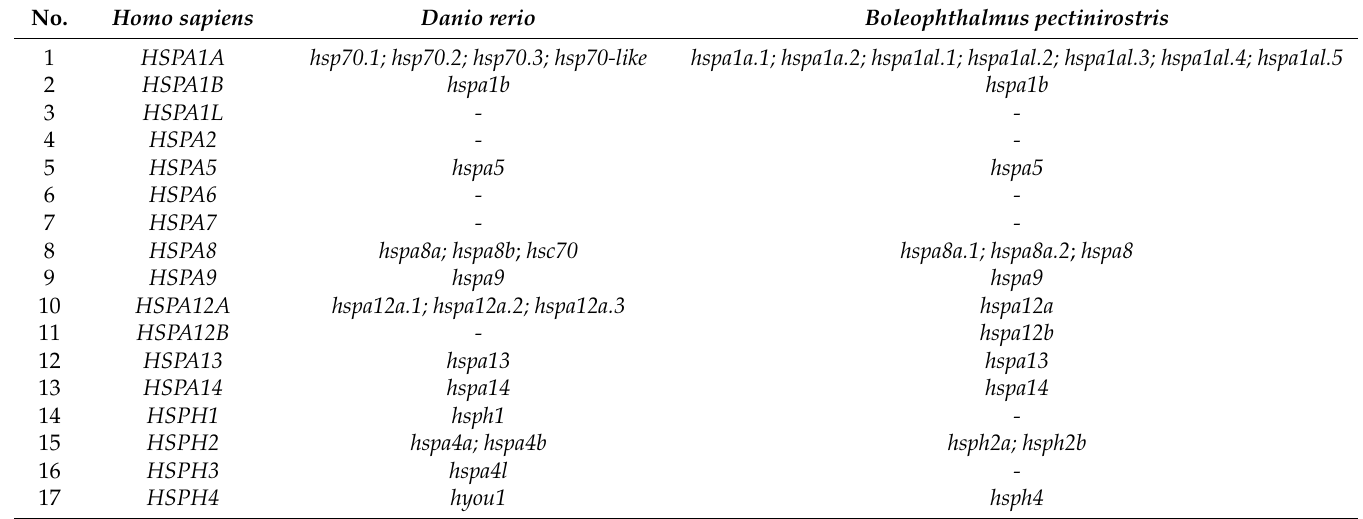
Table 2. HSP70 gene families in human, zebrafish, and B. pectinirostri